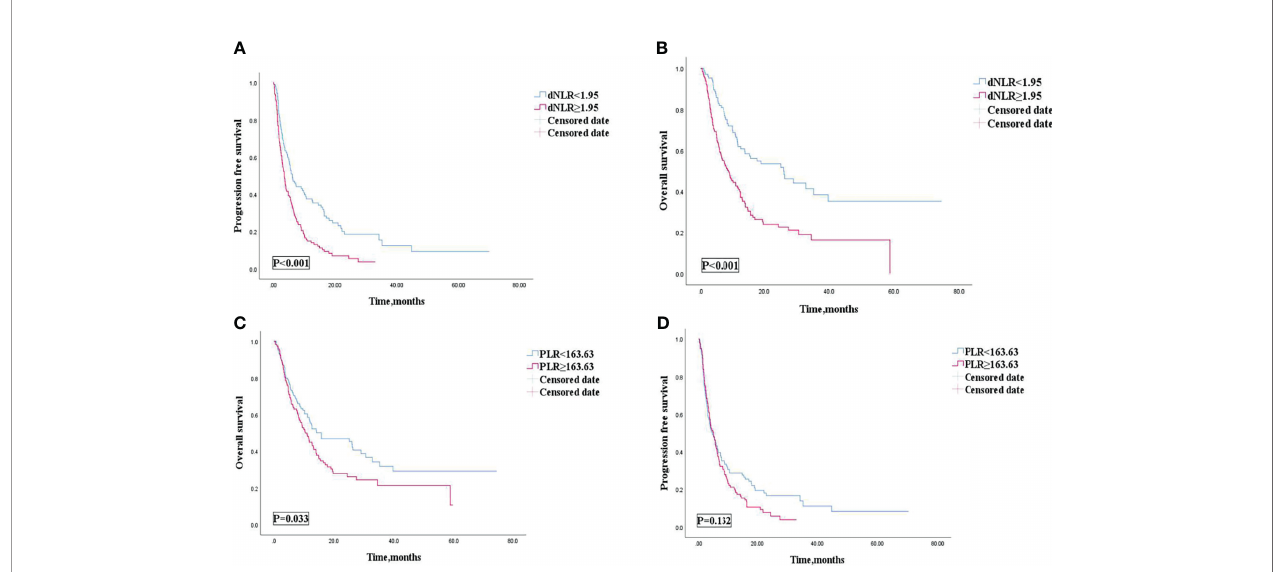
FIGURE 2 | PFS (A) and OS (B) of the dNLR of patients with AGC receiving ICIs cohort, and OS (C) and PFS (D) of the PLR of patients with AGC, receiving ICIs cohort. PFS, progression free survival; OS, overall survival; AGC, advanced gastric cancer; ICIs, immune checkpoint inhibitors; dNLR, derived neutrophil ‐ to ‐ lymphocyte; PLR, platelet – lymphocyte